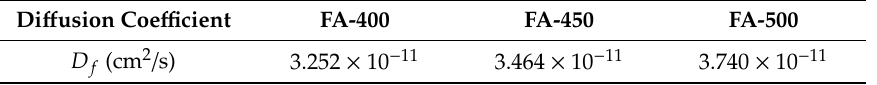
Table 2. Calculated di ff usion coe ffi cients of oxygen in the oxide films obtained by Equation (18). Di ff usion Coe ffi cient